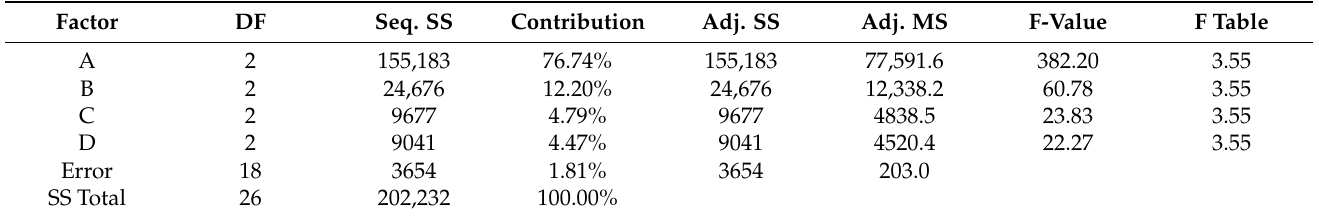
Table 7. The analysis of variance for the flexural strength of SS316 and low-carbon steel weld joints.